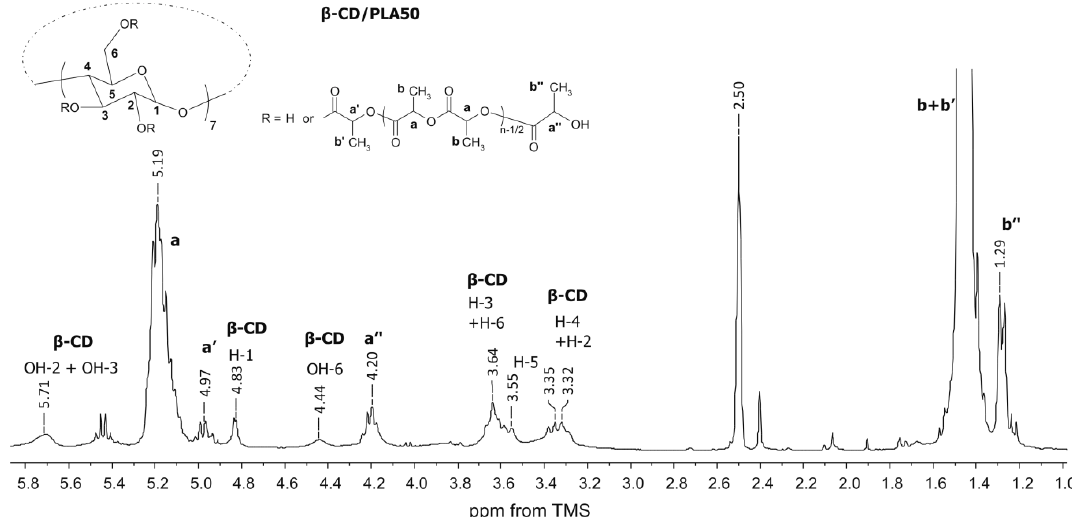
Figure 2. 1 H NMR spectrum of the β -CD/PLA100 polymer.